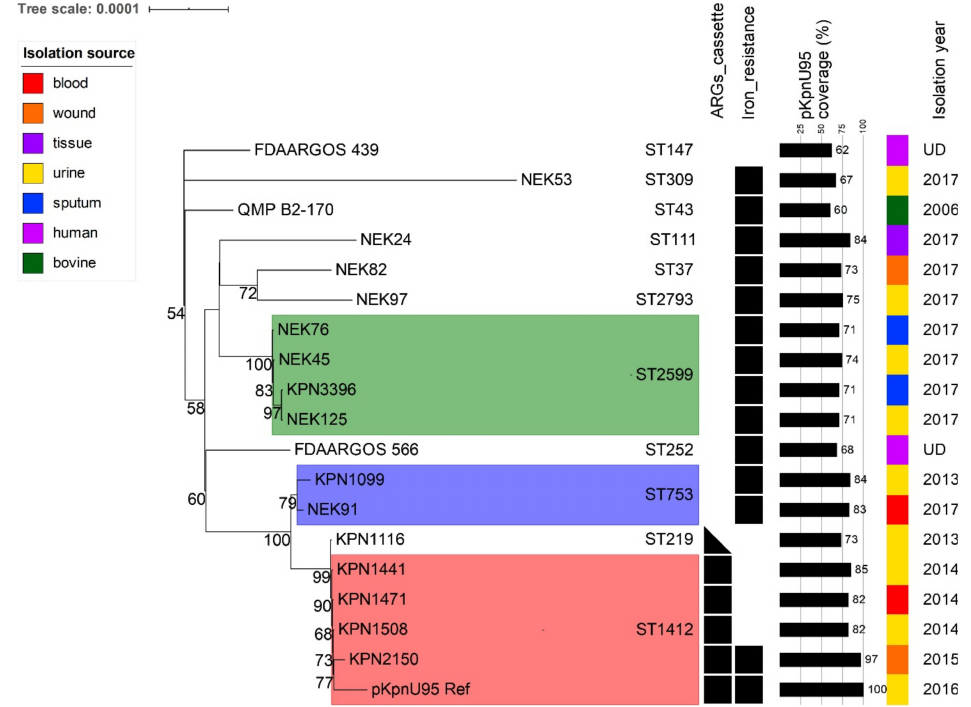
Figure 4. Phylogeny of pKpnU95-related plasmids. The maximum-likelihood tree shows the relationships between concatenated SNPs extracted from pKpnU95 and its related plasmids ( n = 18). Bootstrap support values (>50% out of 1000 replicates) are presented at nodes. Plasmid groups carried by K. pneumoniae isolates of the same ST are highlighted with colors. Plasmid characteristics such as the presence of specific resistance cassettes and pKpnU95 coverage together with host STs, sources and years of isolations are presented on the